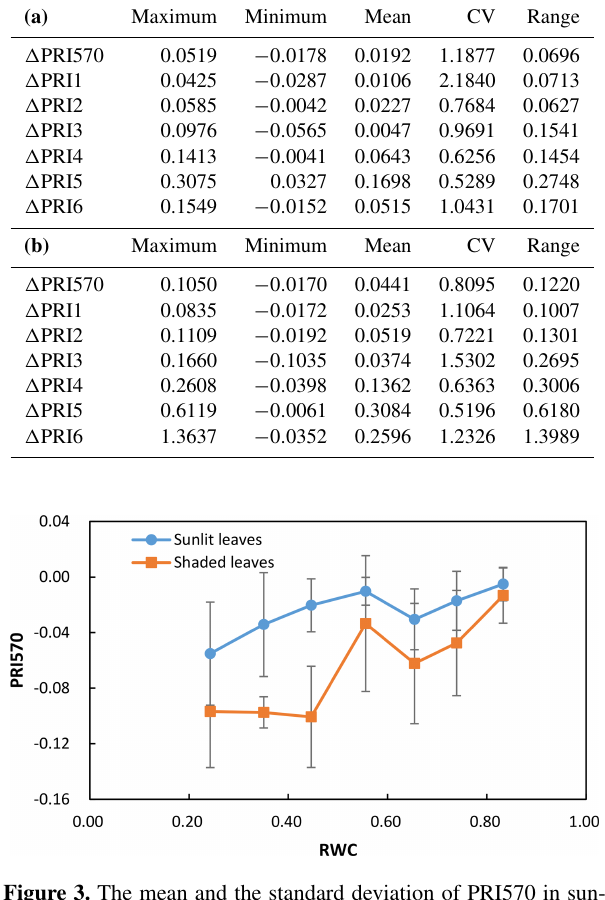
the 100 % shaded-leaf condition. R 2 of the linear